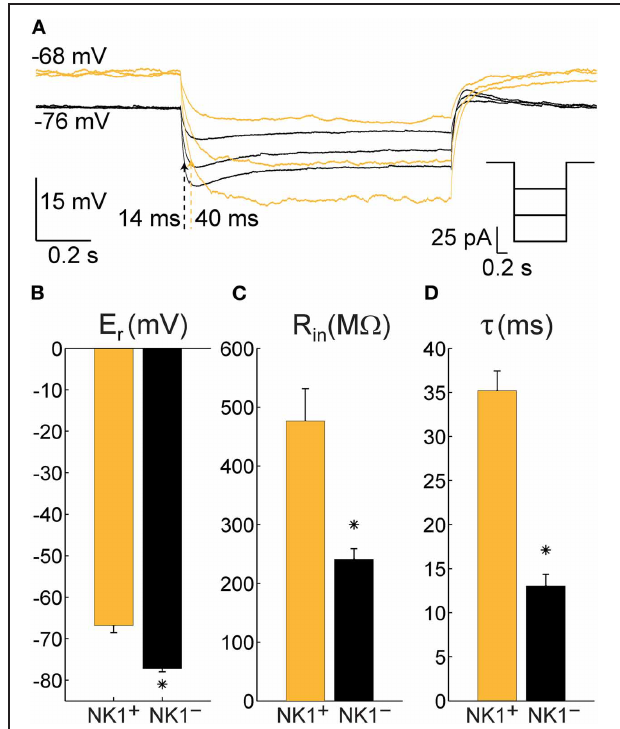
FIGURE 5 | Electrophysiological characteristics of NPY neurons recorded in cortical slices from NPY-hrGFP transgenic mice that are either NK1 + ( N = 14) or NK1 − ( N = 31). (A) Typical single trials of the membrane potential of an NK1 + neuron (orange) and an NK1 − neuron (black) in response to hyperpolarizing current injections showing a large difference in time constant (indicated by dotted arrows) and resting potential. Right inset depicts the injected currents for both neurons. (B) Mean and standard error of the membrane potential at rest ( E r ) for all recorded NK1 + and NK1 − cells. (C) Mean and standard error of the input resistance at rest ( R in ) for all recorded NK1 + and NK1 − neurons. (D) Mean and standard error of the time constant ( τ , calculated as the product between input resistance and capacitance) for all cells where at least three steps of current were injected. The differences between NK1 + and NK1 − were highly significant in all three cases ( p < 3 × 10 − 6